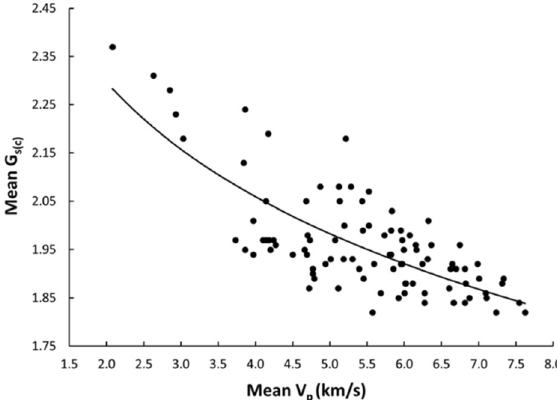
Figure 9. Relationship between the V p and G s(C) of limestone.